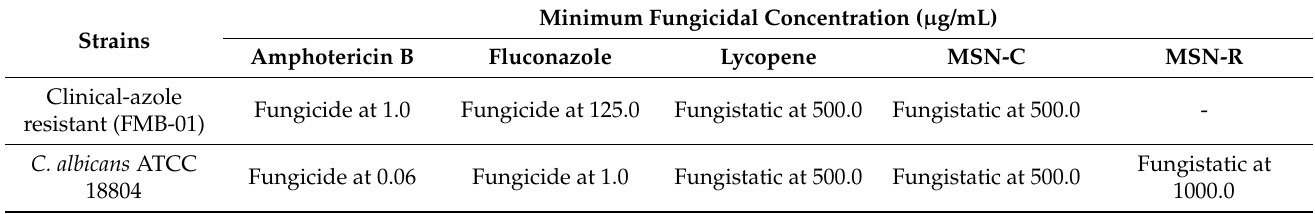
Table 3. The minimum fungicidal concentration of the groups